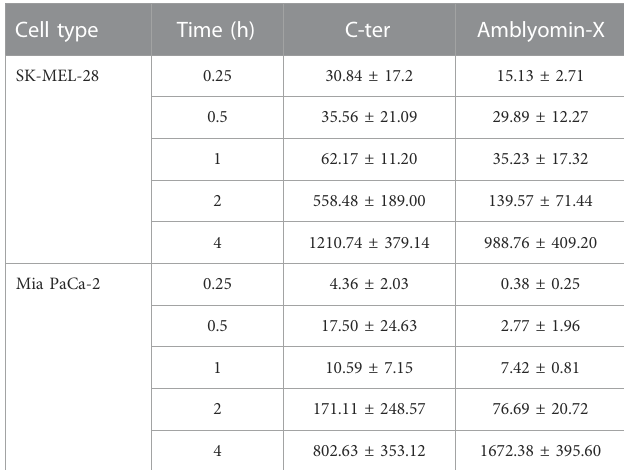
TABLE 3 C-ter acumulation inside the cells faster than Amblyomin-X. Tumor cells were treated with Alexa-Fluor 488-labeled molecules (20 µM) at indicated times. Fluorescence were monitored by a Molecular Devices ImageXpress Micro Confocalplate-scanningmicroscope(MolecularDevices,Sunnyvale,CA).Vesicles counts were analyzed using MetaXpress software (Molecular Devices, CA) with Trans fl uor Application